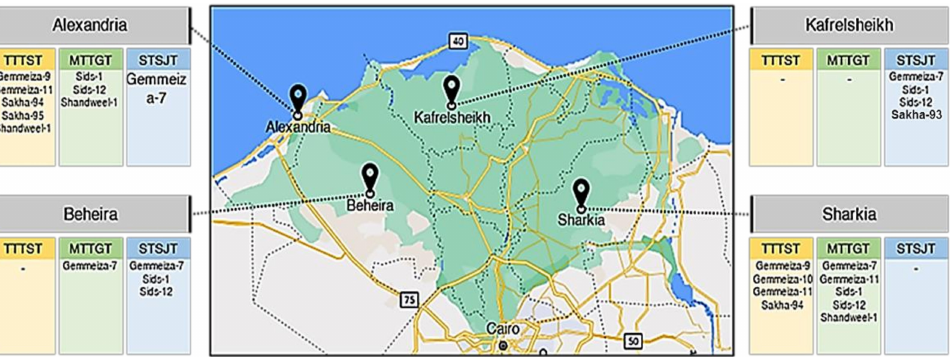
Figure 9. Map of distribution of the most virulent races and frequency (%) on Egyptian wheat cultivars in four different governorates.